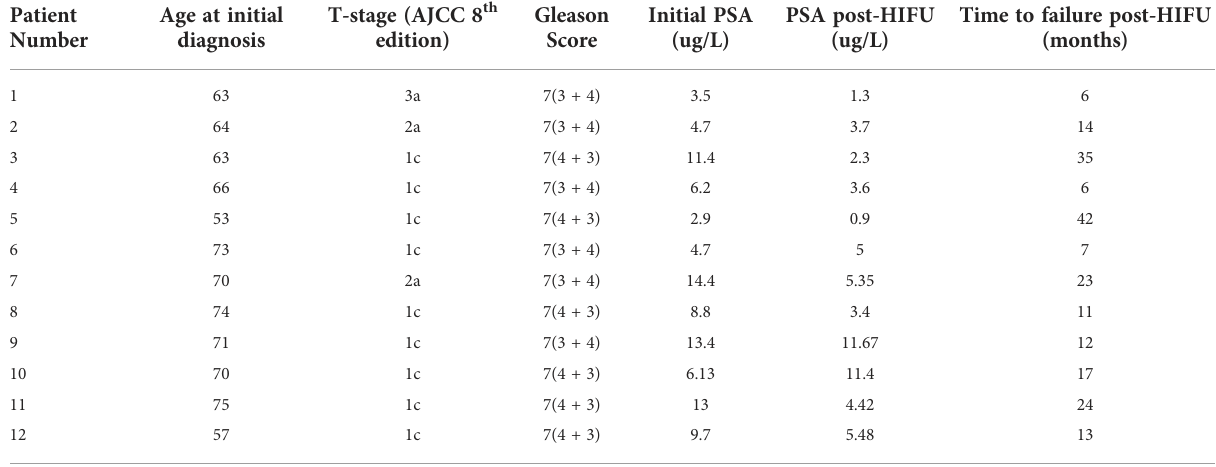
TABLE 1 Baseline patient characteristics at